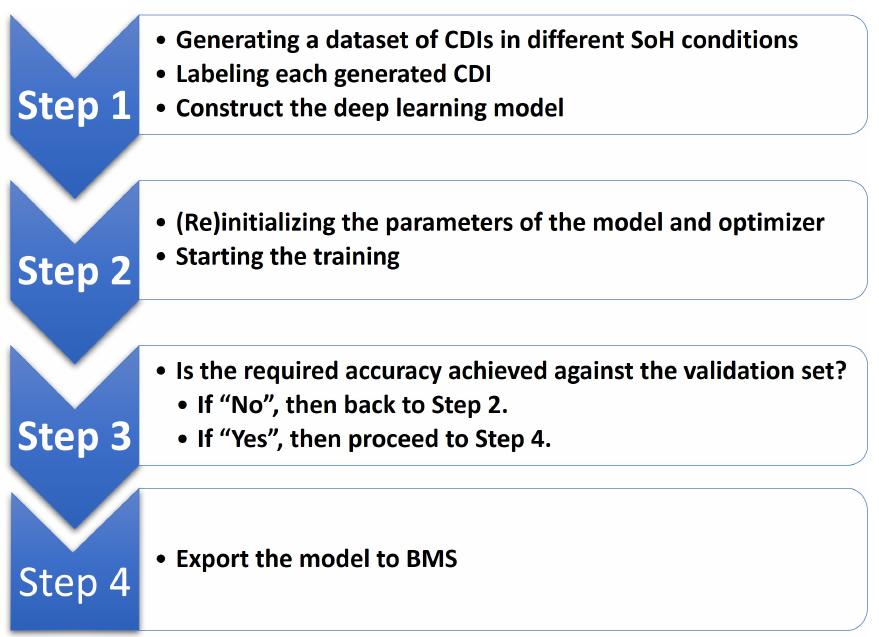
Figure 4. This step diagram shows the process of how a CNN model is trained to characterise the CDIs for the SoH